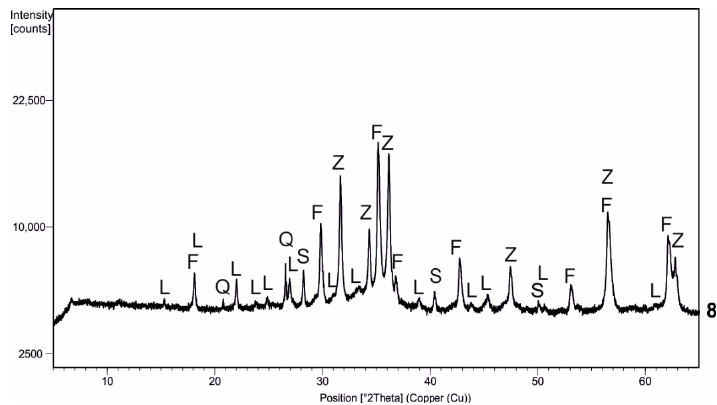
Figure 3. Laurionite particle in dust from de-dusting, sample No. 8: ( a ) SEM image (laurionite is indicated by a red arrow); ( b ) the EDS spectrum.